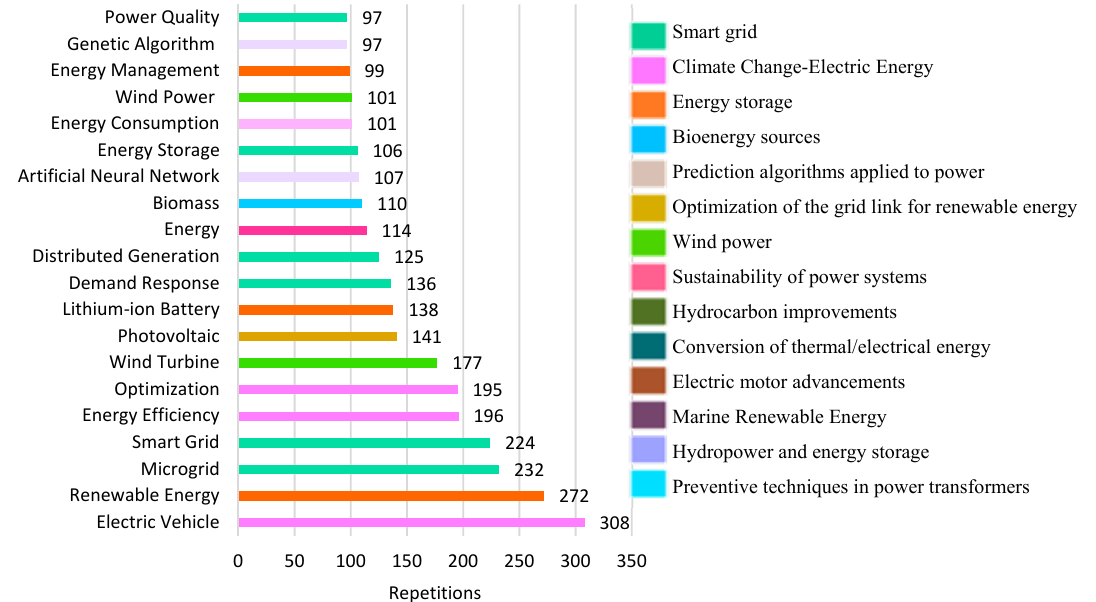
Figure 11. Distribution of keywords and the representation of the communities with the greatest contributions to the globally most representative words.